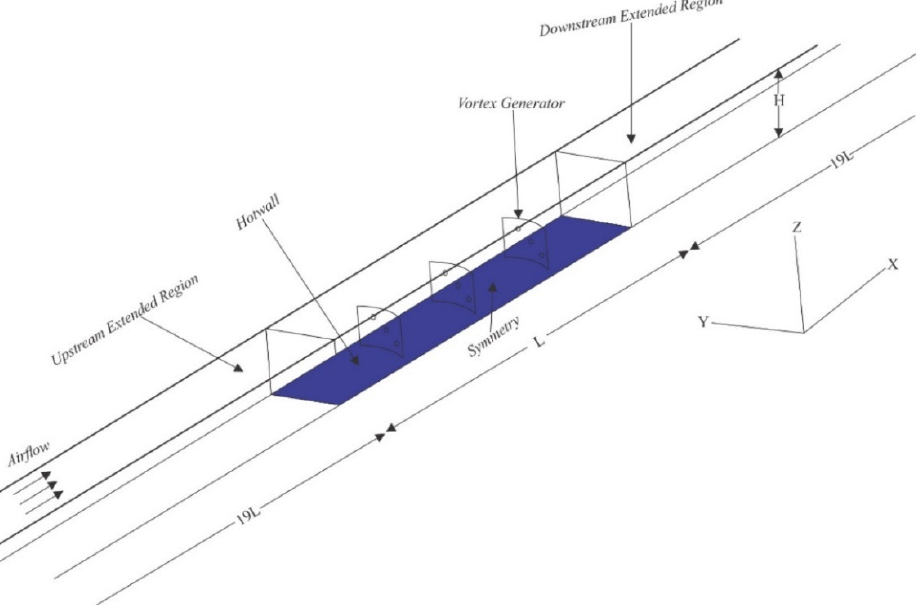
Figure 4. Computation domain.